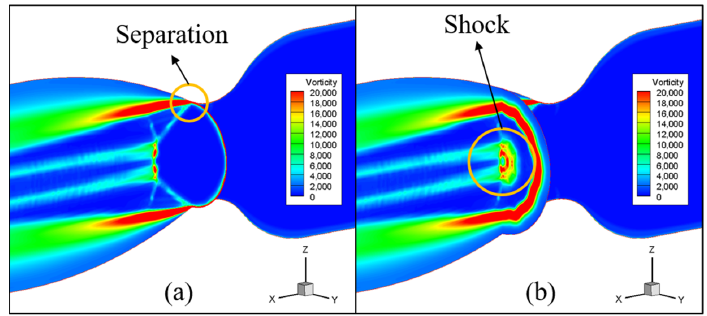
Figure 10. Vorticity contours near throat: ( a ) separation location due to shock-boundary layer interaction; ( b ) shock location at center line.